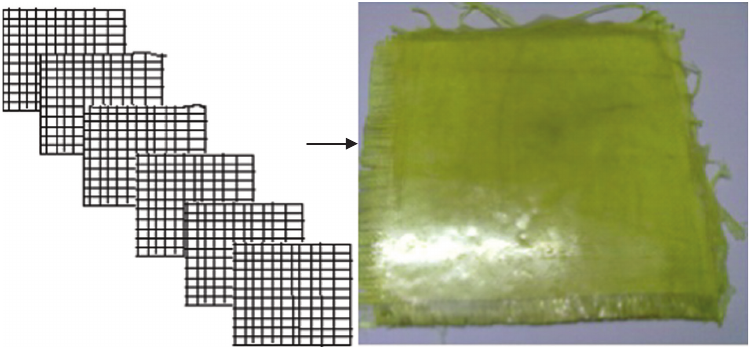
Figure 1 Kevlar/epoxy laminates after fabrication.